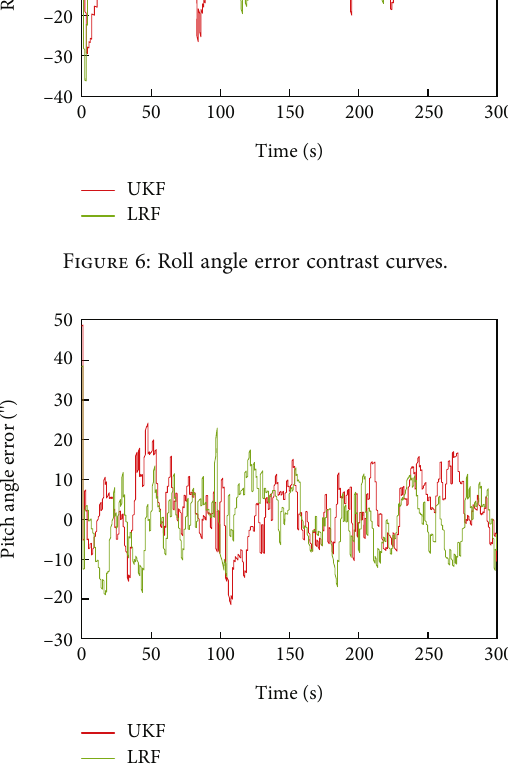
Figure 7: Pitch angle error contrast curves.